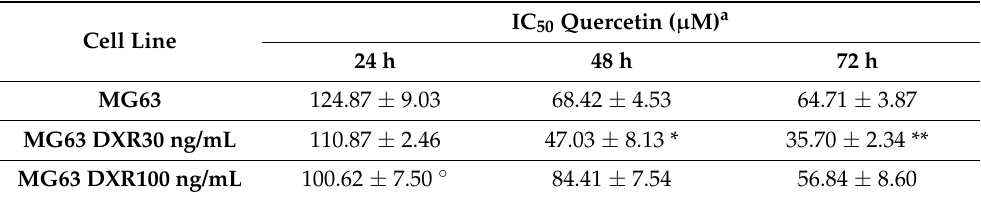
Table 2. Cytotoxic effect of quercetin (calculated as IC 50 ) after 24, 48, and 72 h of treatment in